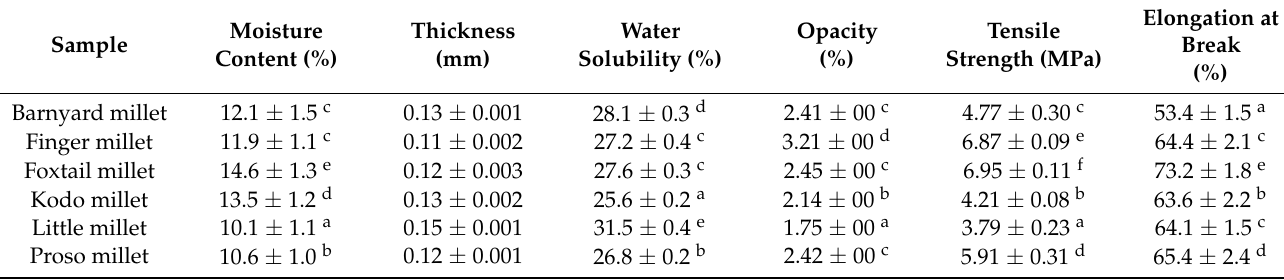
Figure 3. Morphological properties of millet starches—( A ): barnyard millet; ( B ): finger millet; ( C ): foxtail millet; ( D ): kodo millet; ( E ): little millet; ( F ): proso millet. Table 4. Properties of starch